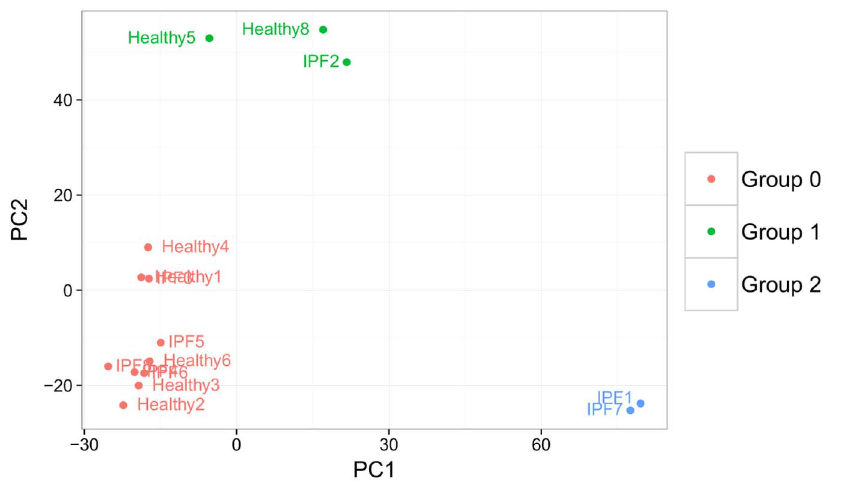
Figure 13. Subject genotypes cluster into three demographic groups. The first two principal components of sample genotype scores separate samples into three clusters.